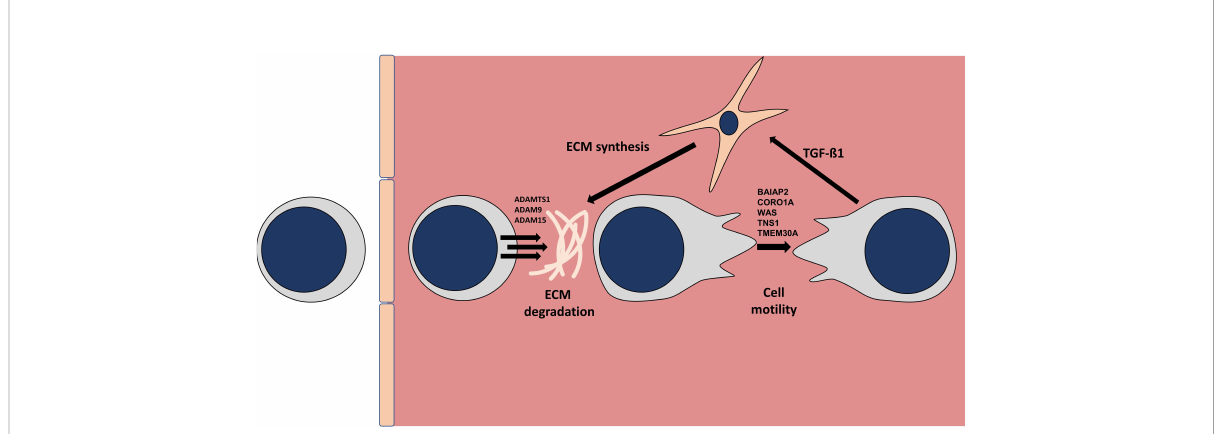
FIGURE 4 Model of myocardial B-cell behavior/function in the healthy myocardium. Diagram depicting a model of B-cells tissue migration in the myocardial interstitial space. Based on the analysis of the genes speci fi cally upregulated in myocardial B-cells as compared to circulating peripheral blood B-cells we hypothesize that B-cells extravasate, degrade the extracellular matrix (ECM) and crawl through the interstitial space where they communicate with other cells such as fi broblasts. The list of genes involved in matrix degradation and diapedesis was generated using Ingenuity Pathway